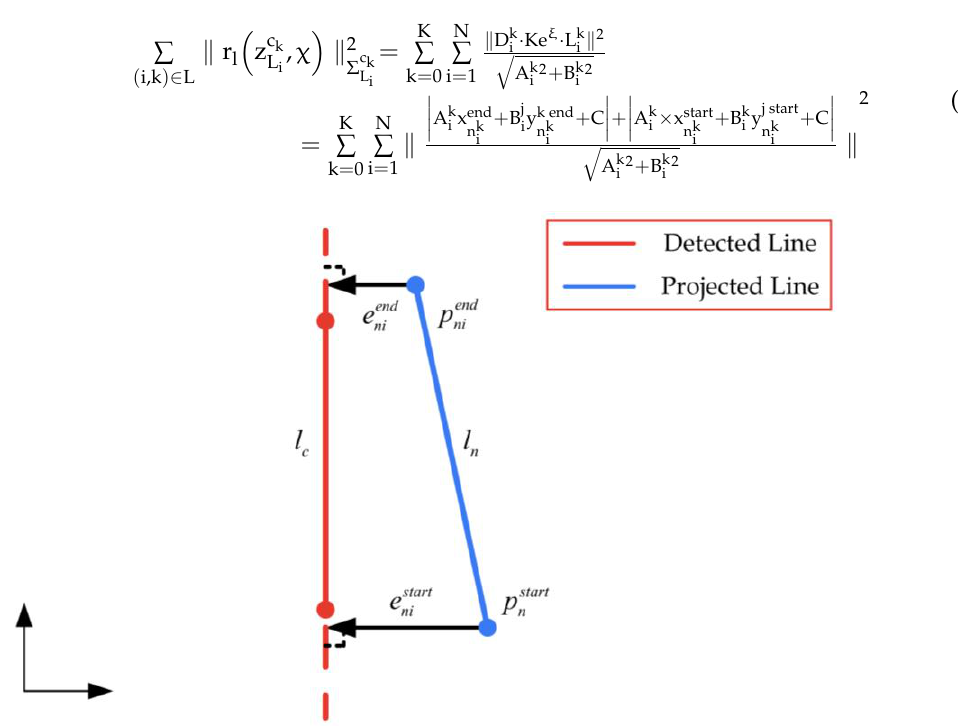
Figure 8. Error of line segment.